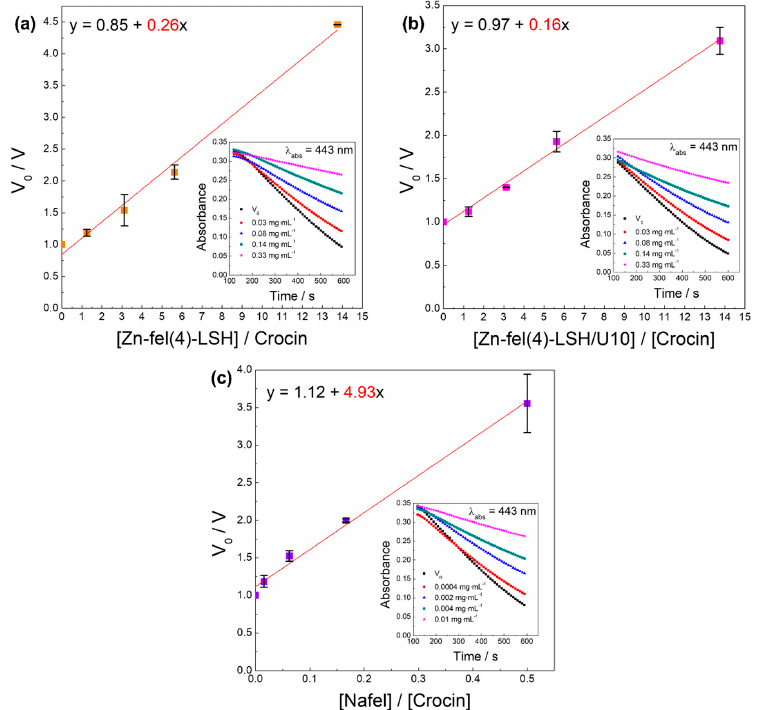
Figure 14. Representation between velocities and concentrations of ( a ) Zn-fel(4)-LSH, ( b ) Zn-fel(4)-LSH/U10, and ( c ) Nafel (NaC 10 H 9 O 4 ) samples in the crocin bleaching assay. V 0 , velocity in the absence of LSH-ferulate materials and Nafel salt; V, velocity in the presence of LSH-ferulate materials and Nafel salt. Table 5. DPPH • , ABTS •+ , HOCl/OCl - , and ROO • scavenging activities of Nafel (NaC 10 H 9 O 4 ), Zn-fel(4)-LSH and Zn-fel(4)-LSH/U10 samples expressed in the EC 50 values and linear regression slopes for the V 0 /V versus [Antioxidant]/[Crocin] graphs. Sample